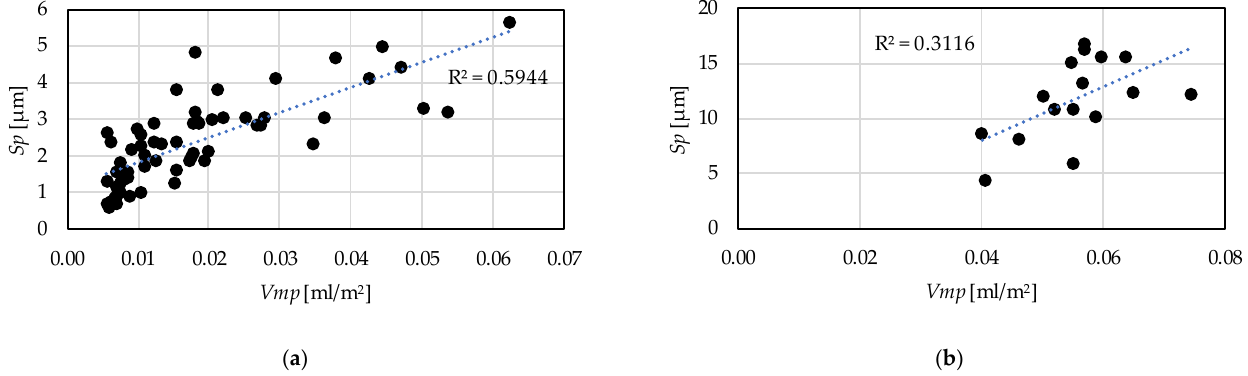
Figure 13. Connection between the peak material volume— Vmp and the maximum height— Sp parameters ( a ) hard turning; ( b ) grinding.